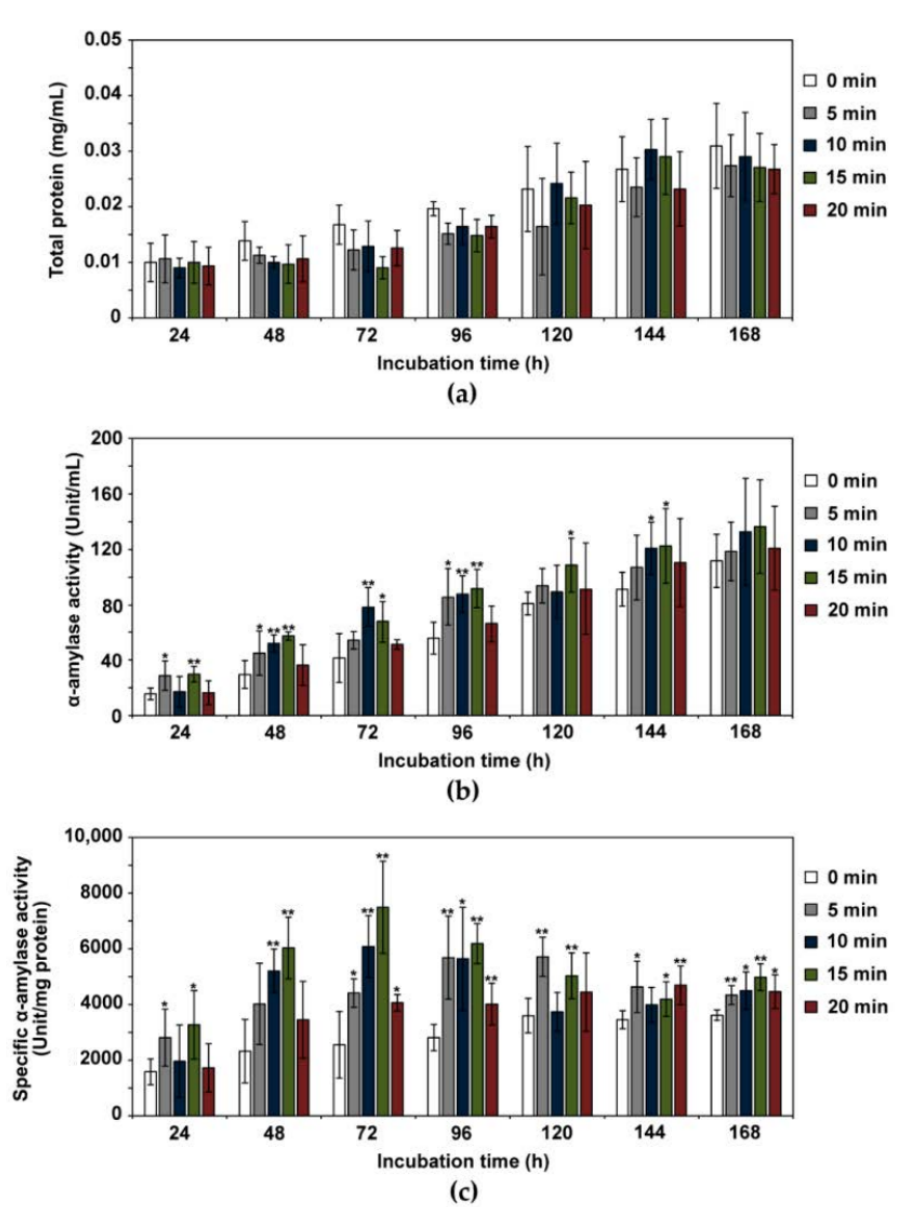
Figure 3. Total protein secretion and α -amylase activity of A. oryzae during incubation post treat- ment with a plasma jet for 5, 10, 15, and 20 min, or without treatment (0 min = control). ( a ) The concentration of total protein in the potato dextrose broth (PDB) media (mg/mL) post incubation for the indicated time periods. ( b ) The α -amylase activity (Unit/mL) detected in the PDB media post incubation for the indicated time periods. ( c ) The specific α -amylase activity (Unit/mg of total protein) estimated in the PDB media post incubation for the indicated time periods. All values were calibrated with the background (0 h incubation) values. Each value is indicated as the mean and standard deviation of 6 replicate measurements. ** p < 0.01 and * p <